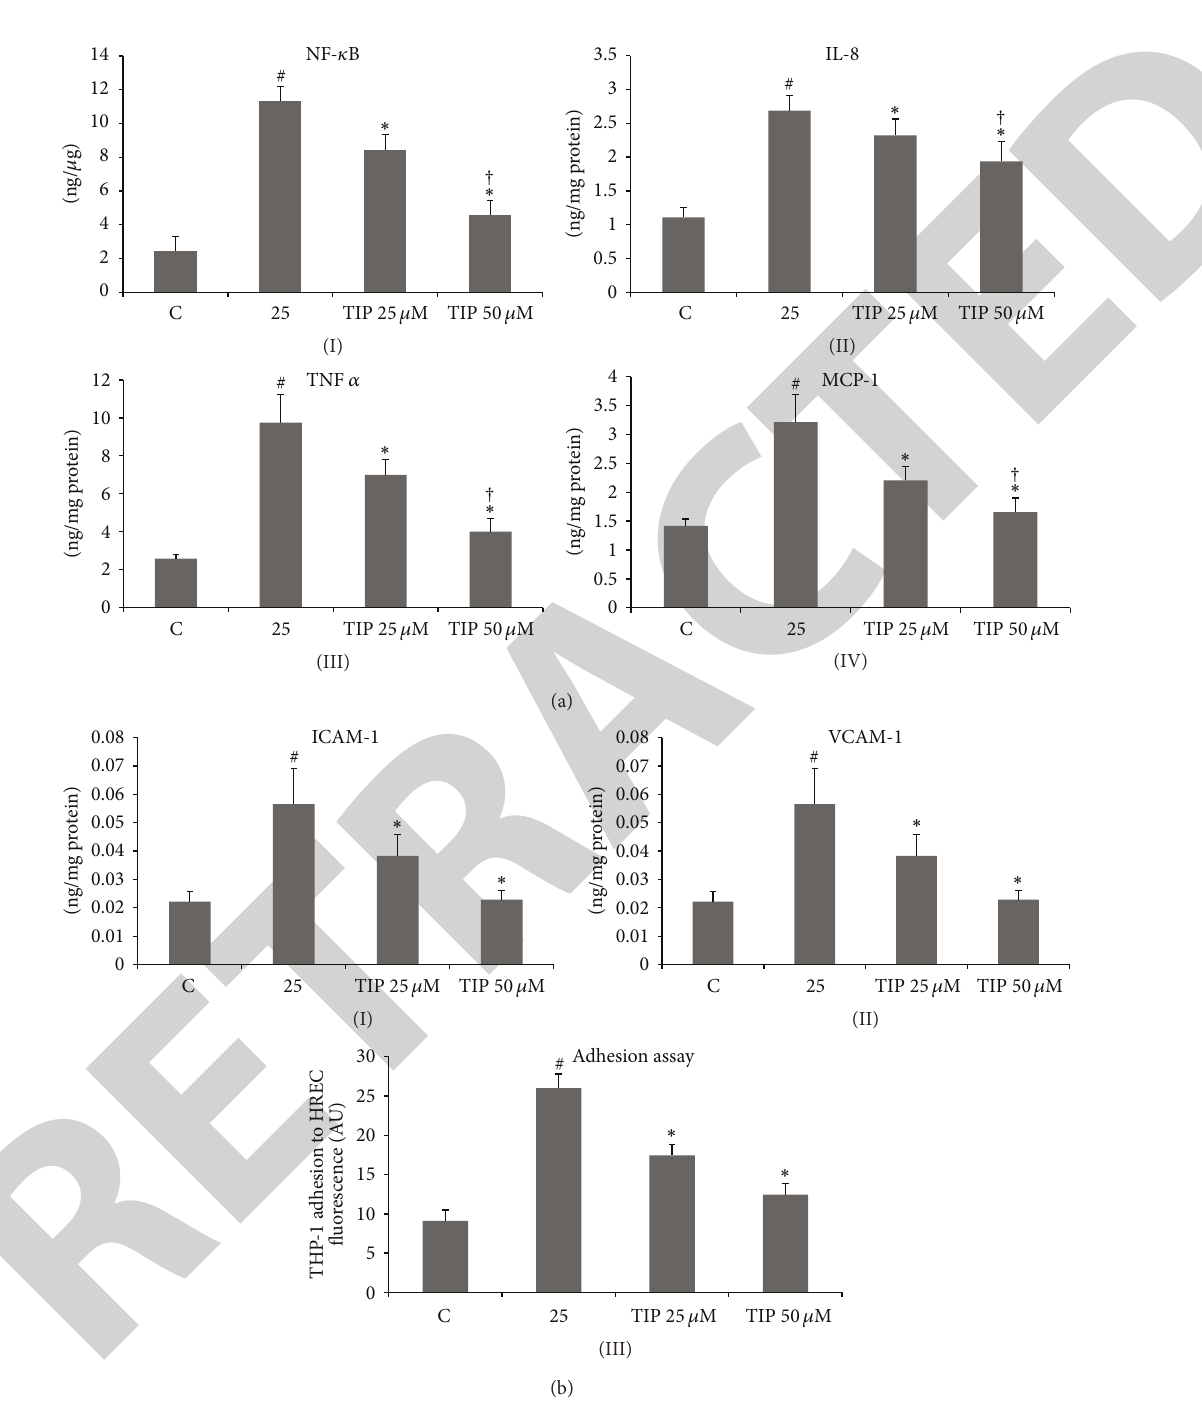
Figure 6: (a) TLR-2/4 inhibition by TIP attenuates downstream inflammatory biomediators: HMVRECs were serum starved for 2 hours and treated with 25 and 50 𝜇 M TIP for 2 hours. Thereafter 5.5 and 25 mM glucose treatments were performed as described in Figure 3. (I) NF- 𝜅 B, (II) TNF- 𝛼 , (III) IL-8, and (IV) MCP-1 levels are significantly decreased upon TLR-2/4 inhibition compared to HG treatment. # 𝑃 < 0.001 versus control, ∗ 𝑃 < 0.001 versus 25 mM, and † 𝑃 < 0.01 versus 25 𝜇 M TIP. (b) Cell adhesion molecules ICAM-1 and VCAM-1 attenuation upon TIP treatment. HMVRECs were serum starved for 2 hours and treated with 25 and 50 𝜇 M TIP for 2 hours. Thereafter 5.5 and 25 mM glucose treatments were performed as described in Figure 4. Adhesion molecules (I) ICAM-1 and (II) VCAM-1 levels are significantly decreased upon TIP treatment. # 𝑃 < 0.001 versus control and ∗ 𝑃 < 0.001 versus 25 mM. (III) Adhesion assay showing decreased cell adhesion with TLR-2/4 inhibition. # 𝑃 < 0.001 versus control and ∗ 𝑃 < 0.01 versus 25